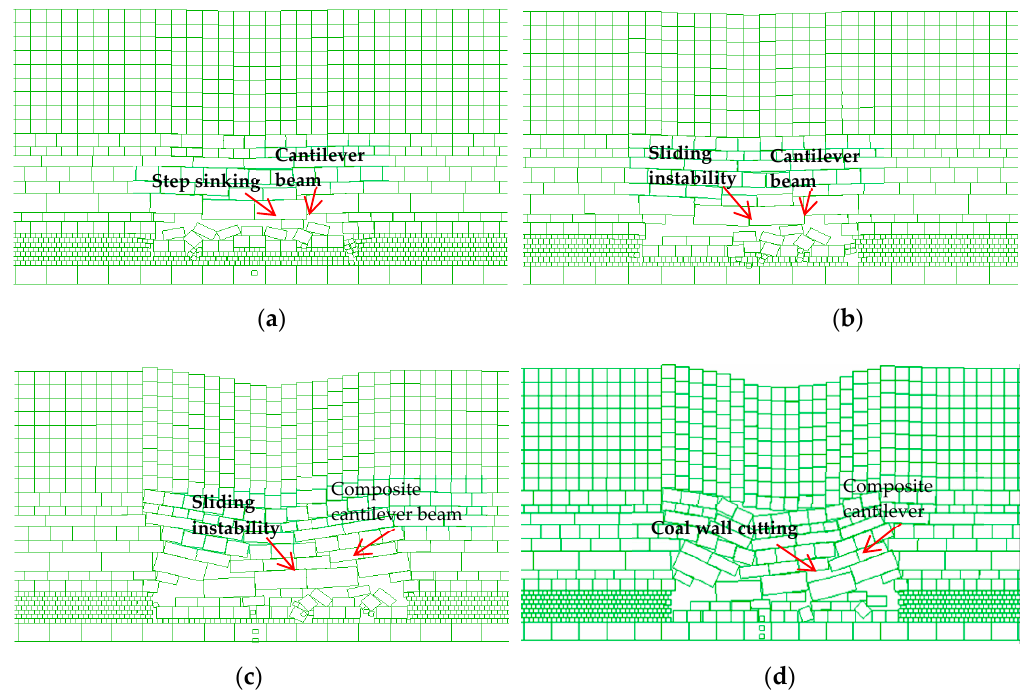
Figure 6. First weighting of working face with 4–7 m mining height: ( a ) 4 m, advance 10 m each step, and L = 40 m first weighting; ( b ) 5 m, advance 10m each step, and L = 40 m first weighting; ( c ) 6 m, advance 10 m each step, and L = 50 m first weighting; ( d ) 7 m, advance 10 m each step, and L = 50 m first weighting.